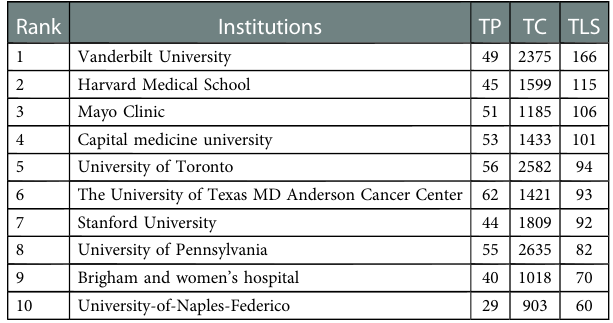
TABLE 2 The top 10 institutions involved in